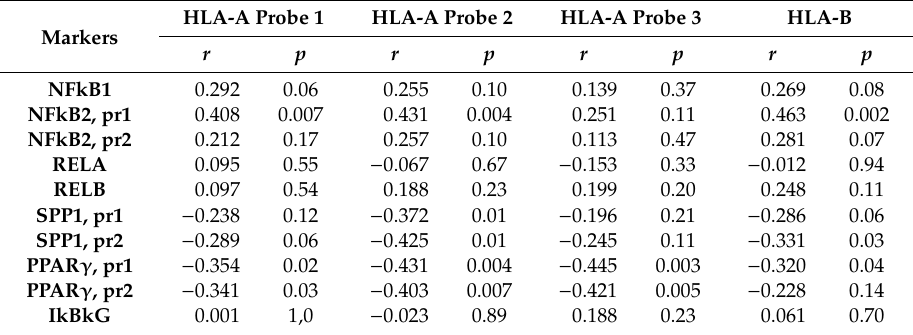
Table 4. Correlation between the NFkB pathway molecules and HLA Class I expression, after exclusion of one-third of the tumors with the highest infiltrate, based on CD8 expression ( n = 43). r = two-tailed Spearman correlation coe ffi cient. p ≤ 0.05 is considered significant.